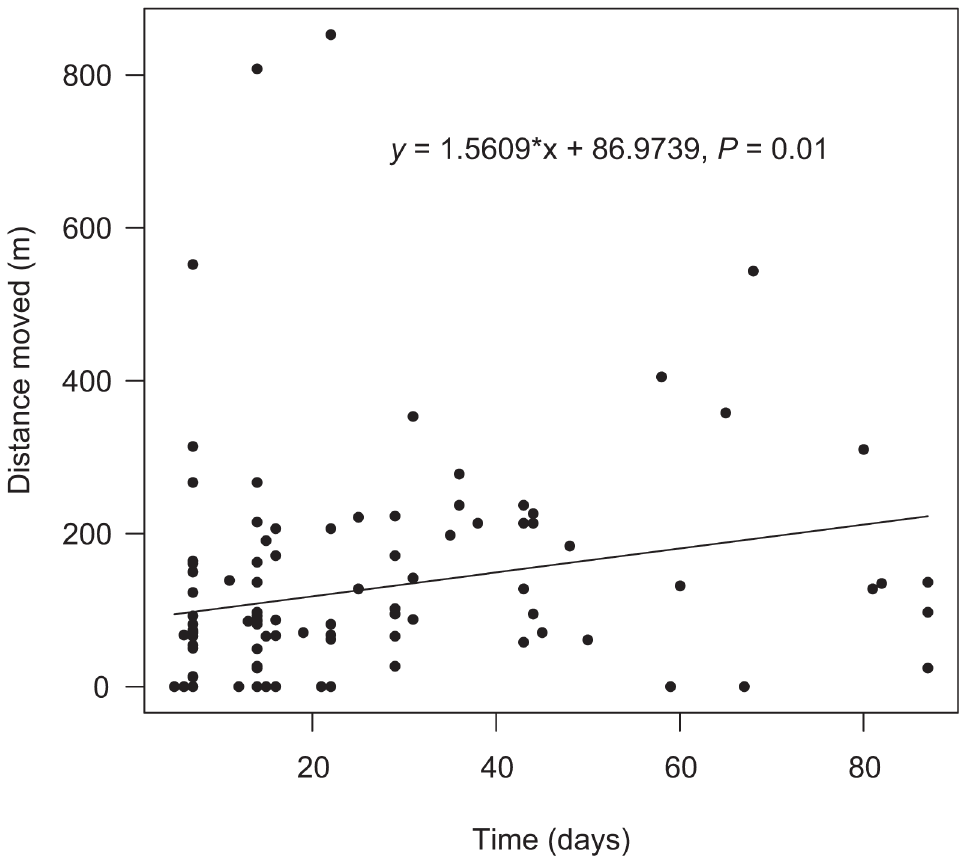
Fig 2. Linear model of movement distance (m) and time (d) for recaptured Scarabaeinae, including recaptures at same trap.